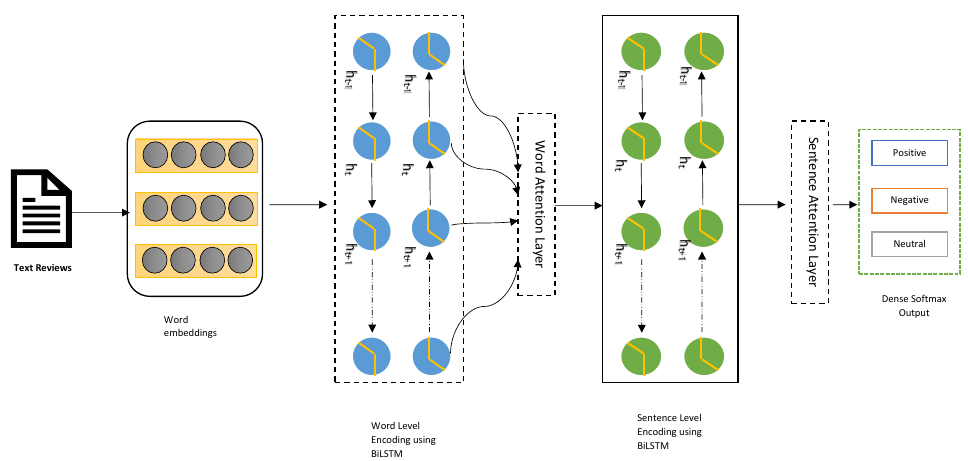
Figure 2. Attention-based bidirectional long short-term memory RU-BiLSTM